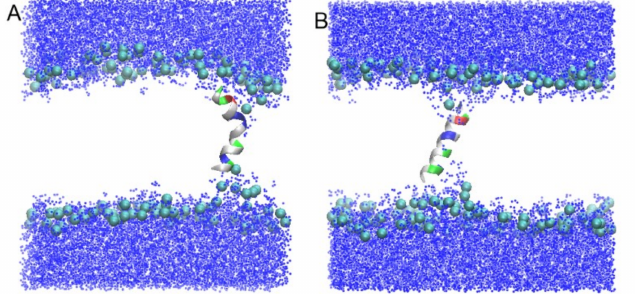
Figure 3. Snapshots of the systems for the simulations Tr5 ( A ) and Tr6 ( B ). Lipid tails are hidden for